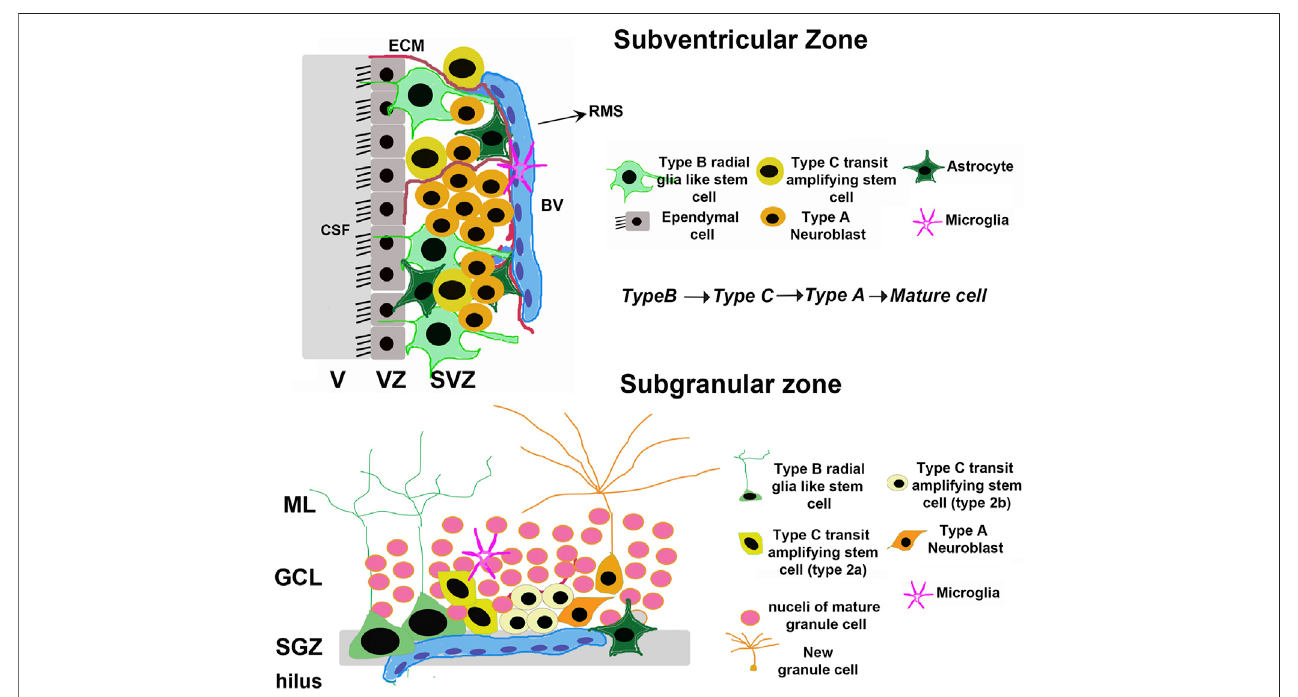
FIGURE1| Adult neural stem cellniches.Schematic depicting the generalorganization ofadult mammalian neural stem cellniches, taking rodents as anexample. The major niches are located in the Subventricular Zone (SVZ) in the forebrain and Subgranular Zone (SGZ) in the dentate gyrus of the hippocampus. V, Ventricle; VZ, Ventricular zone; CSF, Cerebrospinal fl uid; BV, Blood vessel; ECM, Extracellular Matrix; RMS, Rostral Migratory Stream; GCL, Granule Cell Layer; ML, Molecular Layer.